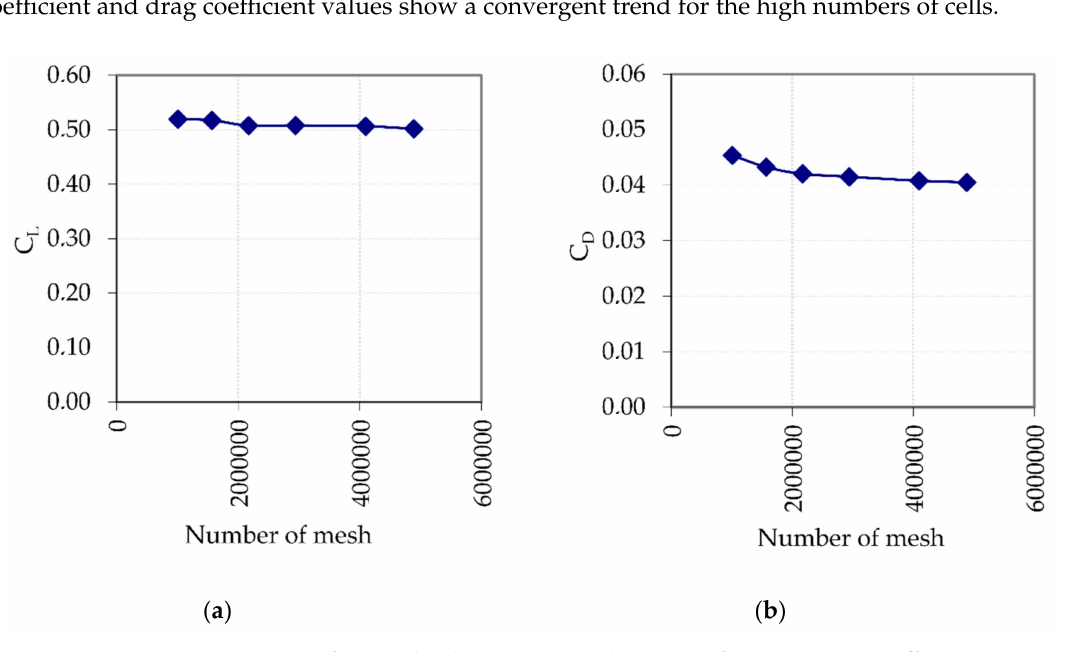
Figure 5. Visualization of the grid independency analysis: ( a ) Lift and ( b ) Drag coe ffi